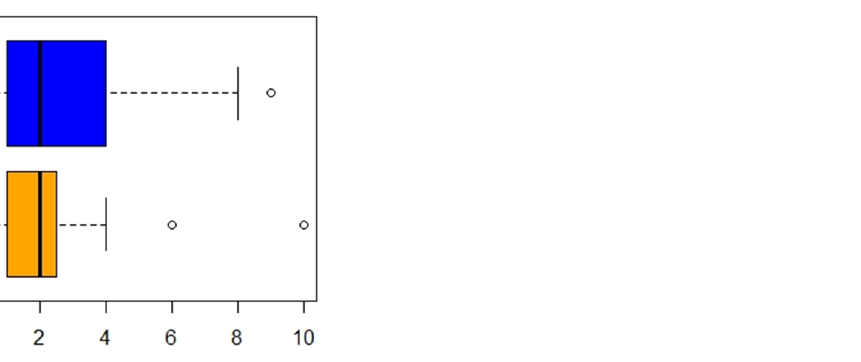
12 of 19 Table 9. Descriptive analysis for the contextual cues intervention. Pre-Test: Number of Pupils Post-Test: Number of Pupils Score range 0–3 6/27 The results from a Wilcoxon signed rank test between the pupils’ pre-test scores (M: 2.44, SD: 2.56, range: 0–10) and post-test scores (M: 3.11, SD: 2.50, range: 0–9) showed that the attendance of the intervention did not result in a statistically significant enhancement in the vocabulary performance ( p > 0.1) (see Figure 3). Non-significant results were also